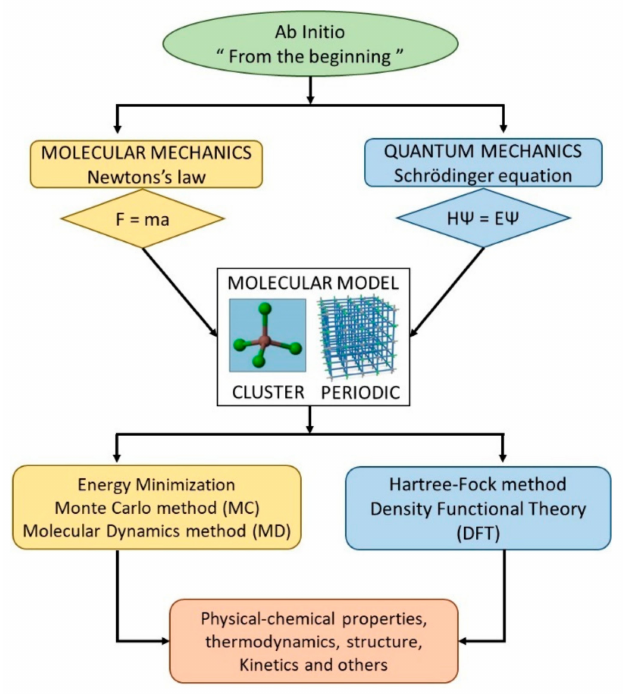
Figure 2. Diagram of molecular mechanics and quantum mechanics